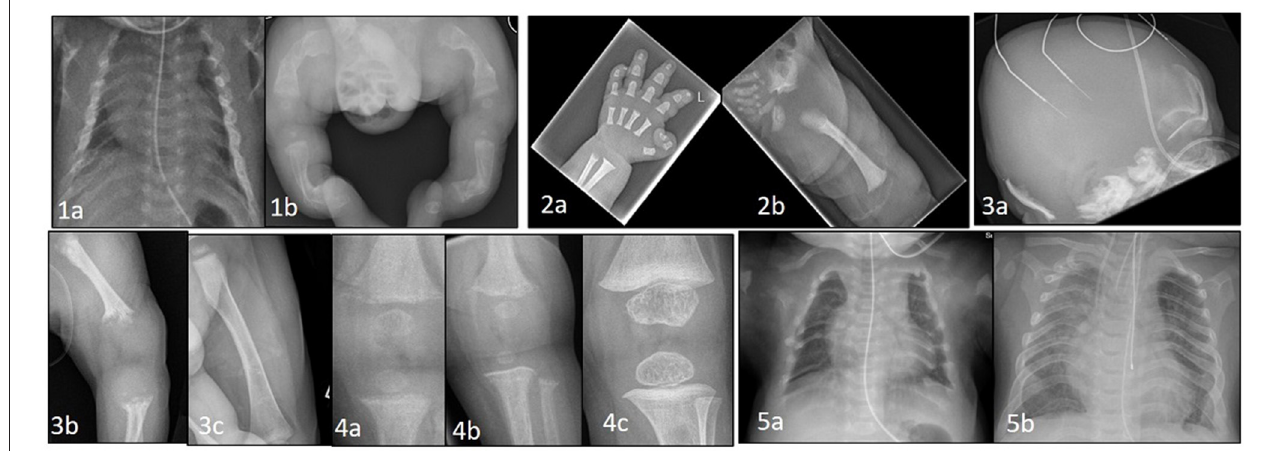
FIGURE 1 | (1a) Thin, gracile and beaded ribs in a case of severe osteogenesis imperfecta at birth. (1b) Lower limbs showing bowing and deformity of long bones with multiple fractures in various stages of healing. (2a) Hand x-ray in achondroplasia showing short metacarpals and phalanges with trident sign. (2b) Hip shows classic features of horizontal acetabular roof, squared off iliac crest, small sacrosciatic notch, and scalloping of proximal femur. (3a) Perinatal hypophosphatasia at birth showing severe skull hypomineralization. (3b) severe hypomineralization of long bones and metaphyseal lucencies. (3c) Healing of metaphyseal lesions and markedly improved mineralization after 12 months of asfotase alfa treatment. (4a) Knee x-ray in a case of NHSPT at 3 months showing metaphyseal irregularity, coarsening of trabeculae, and subperiosteal resorption. (4b) progressive changes at 6 months, and (4c) complete healing following total parathyroidectomy. (5a) Chest X-ray at birth in a baby with TRPV6 mutation. Ribs are malformed with severe demineralization. (5b) Spontaneous improvement at 2 years of age with remodeling, improved mineralization of ribs and thoracic